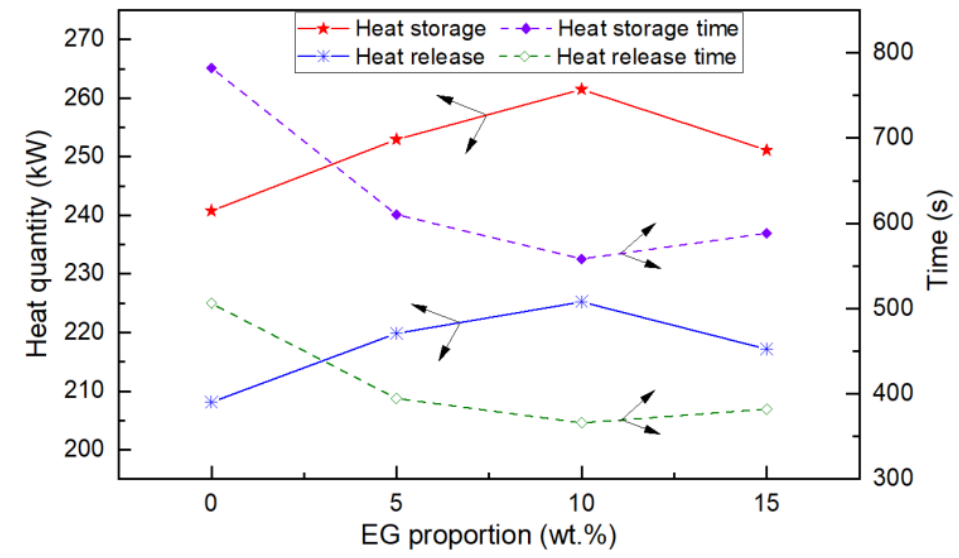
Figure 15. Heat storage, heat release, and time statistics.